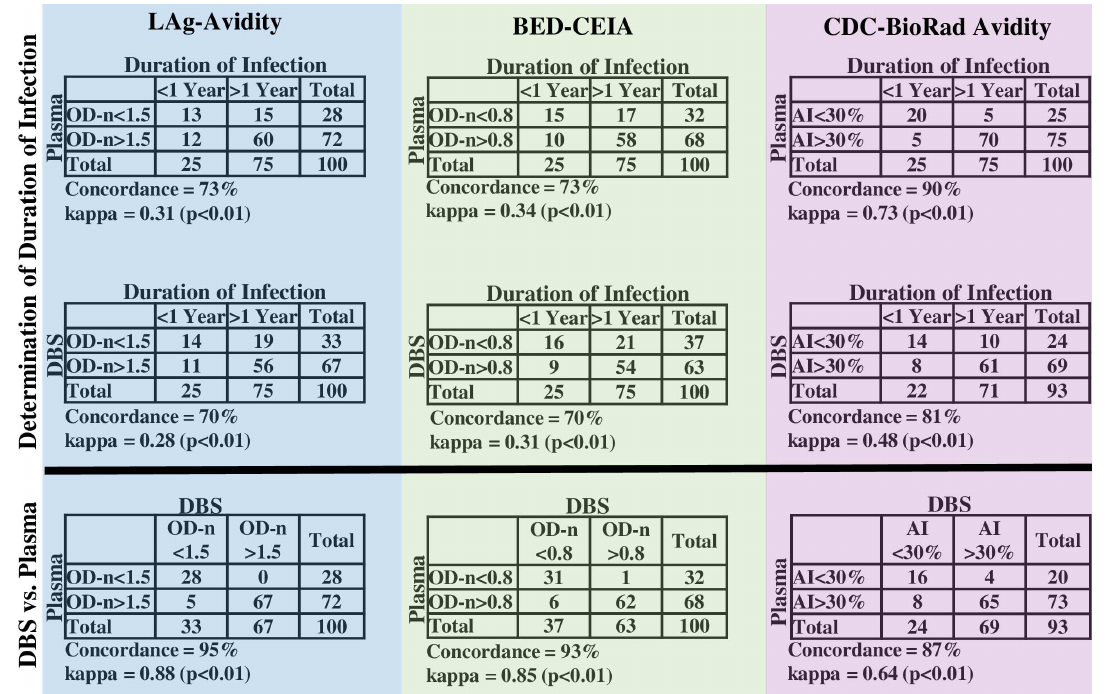
Fig 3. Comparison of categorical results obtained from epidemiologic data and results obtained by testing plasma and DBS samples. Results from LAg-Avidity (highlightedin blue), BED-CEIA (highlightedin green), and CDC-BioRad Avidity (highlightedin